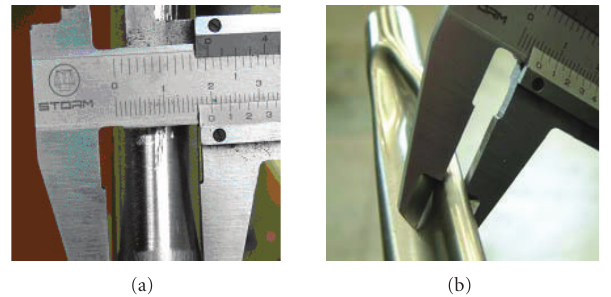
Figure 12: Schematic A and B tubes deformation after buckling. Table 3: Experimental buckling pressure load. Test n